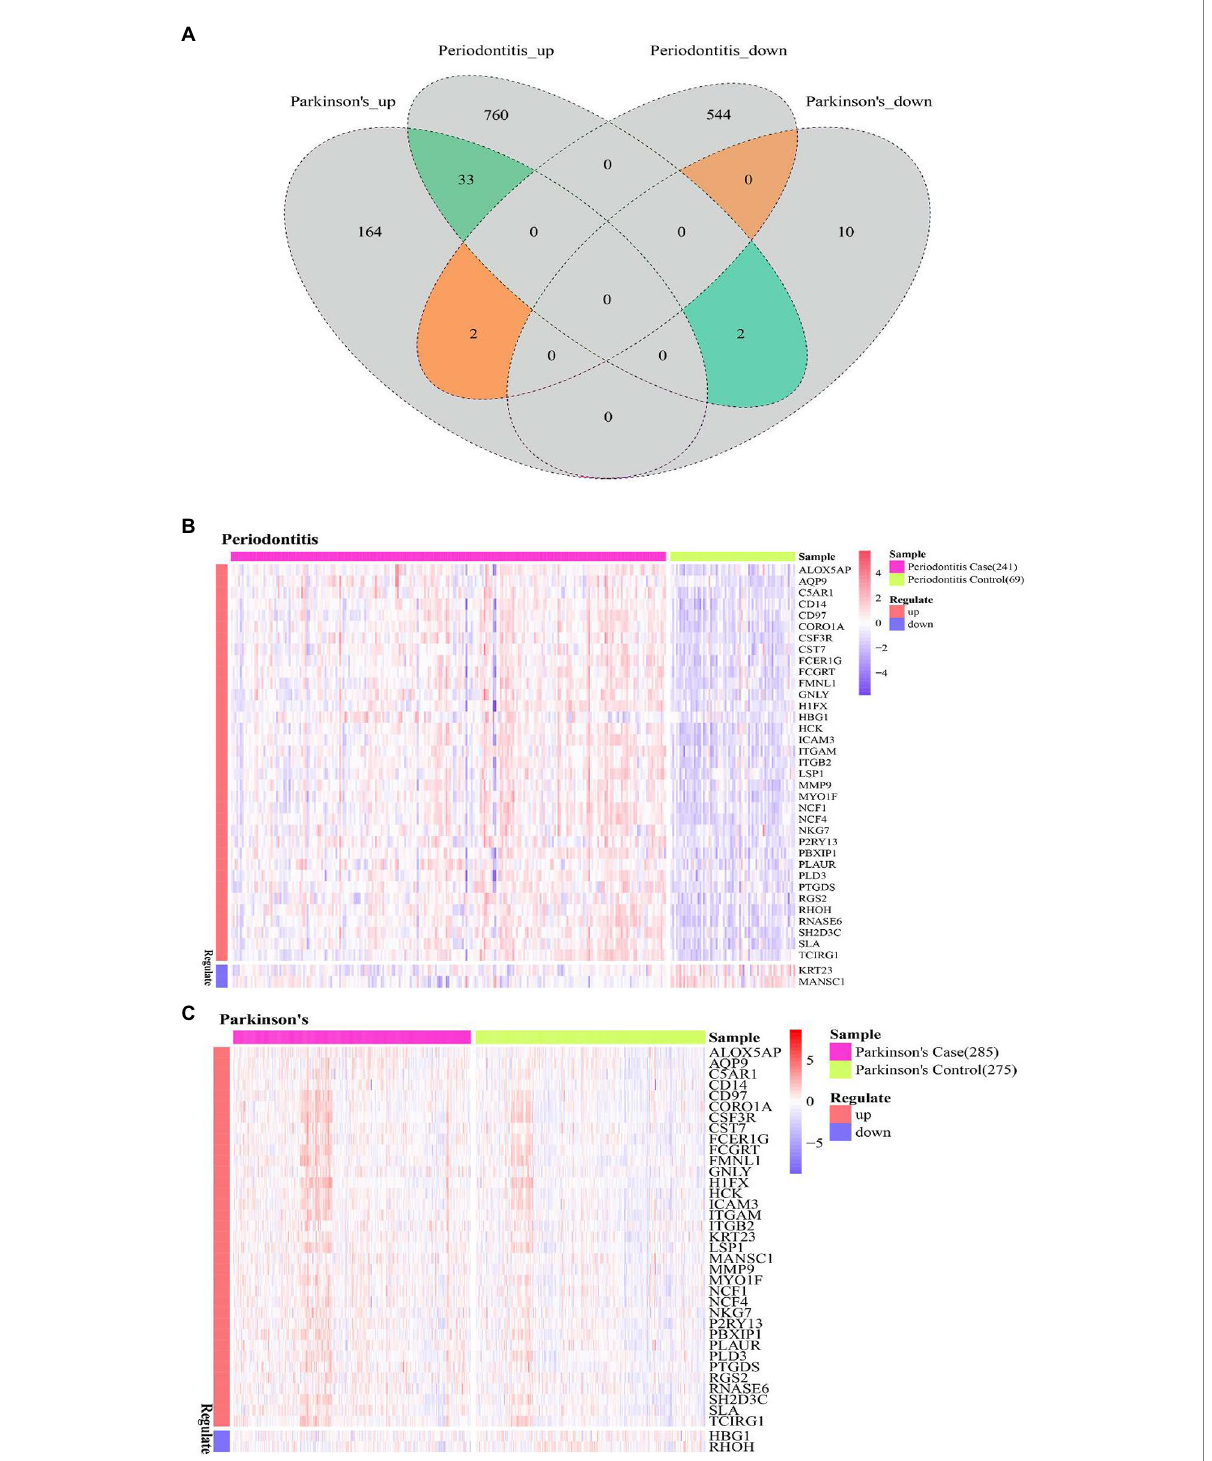
FIGURE 4 Cross-talk gene expression level. (A) Venn diagram of periodontitis disease and Parkinson’s disease differentially expressed genes; (B,C) cross-talk gene at the level of expression of Periodontitis disease and Parkinson’s